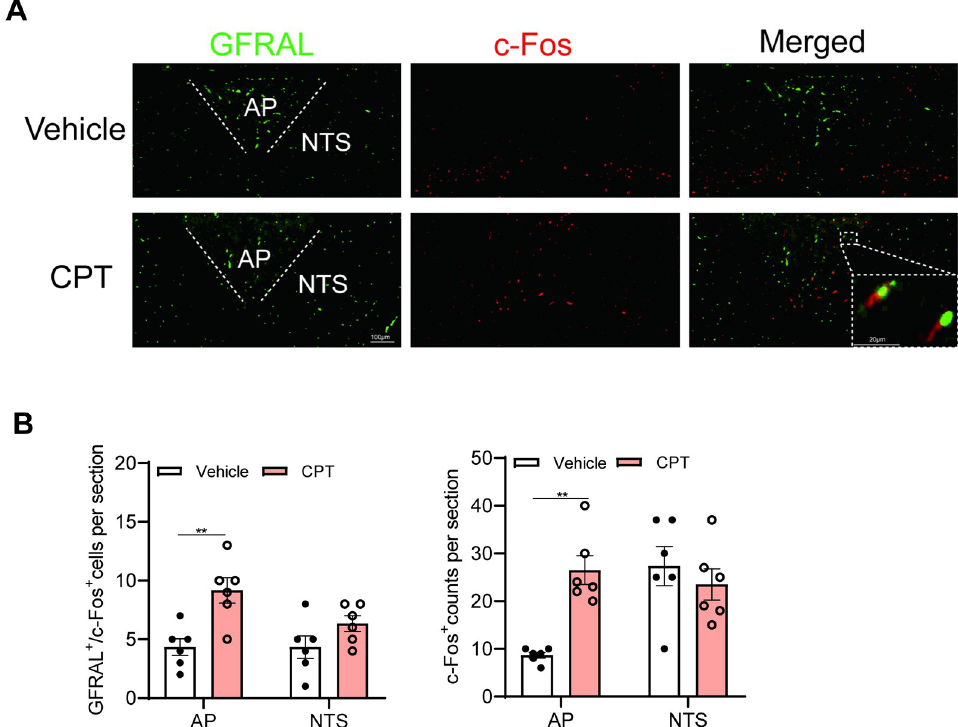
Fig 6. Neuronal activation in CPT-treated mice. DIO mice (weighing 40 to 42 g) received vehicle or CPT (1 mg kg − 1 ); 60 min later, brains were harvested, and tissue sections were subjected to immunofluorescence staining with anti-c-Fos (red) and anti-GFRAL (green). (A) Representative immunofluorescence image of the AP/NTS in CPT- or vehicle- treated DIO mice showing the distribution of GFRAL neurons and the colocalization with the marker of neuronal activation c-Fos. (B) Quantification of CPT-induced c-Fos expression in the AP/NTS ( n = 6 per group). Data are presented as mean ± SEM. � P < 0.05, �� P < 0.01, ��� P < 0.001. The underlying data for this figure can be found in S1 Data . AP, area postrema; CPT, Camptothecin; DIO, diet-induced obese; GFRAL, GDNF receptor alpha-like; NTS, nucleus tractus solitarius.